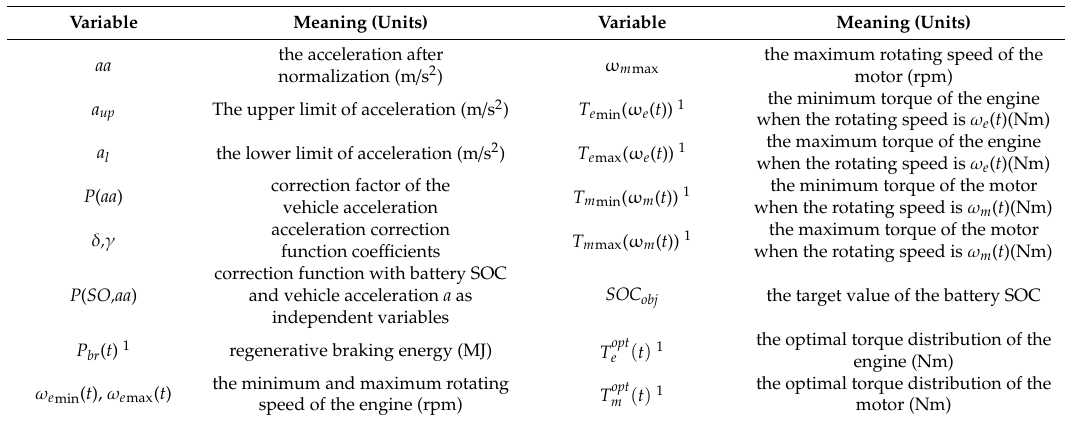
Table 7. Improved ECMS model